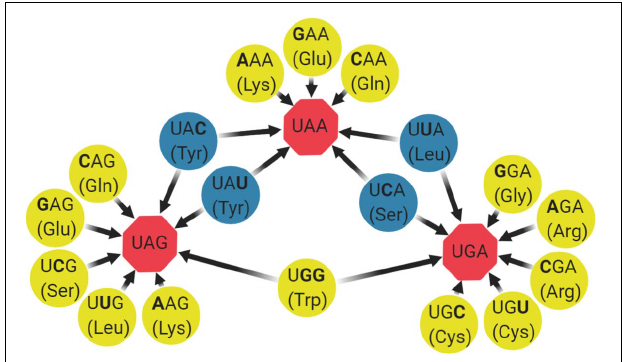
FIGURE 2 | Codons containing non-sense mutation targets. From the 64 codons in the genetic code, 18 codons containing 19 different non-sense mutation targets can mutate to a stop codon after a single-base substitution (boldfaced). In most of the cases, only one of the three possible substitutions produces a stop codon (yellow circles), whereas in some scenarios, two of the three substitutions produce a stop codon (blue circles). Stop codons are represented by red